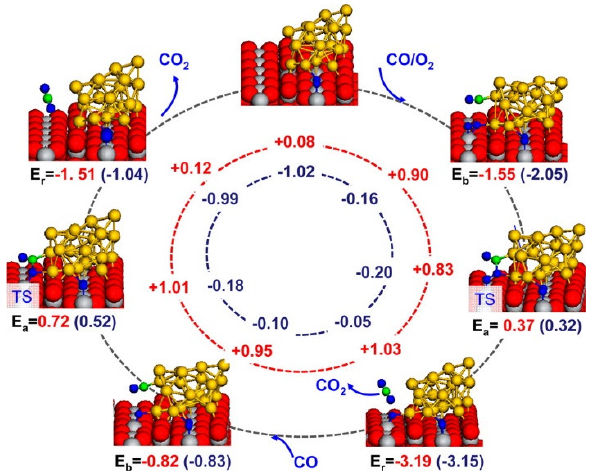
Figure 5. Charge cycle and catalytic cycle for CO oxidation reaction [82]. Copyright 2013, ACS Publications.